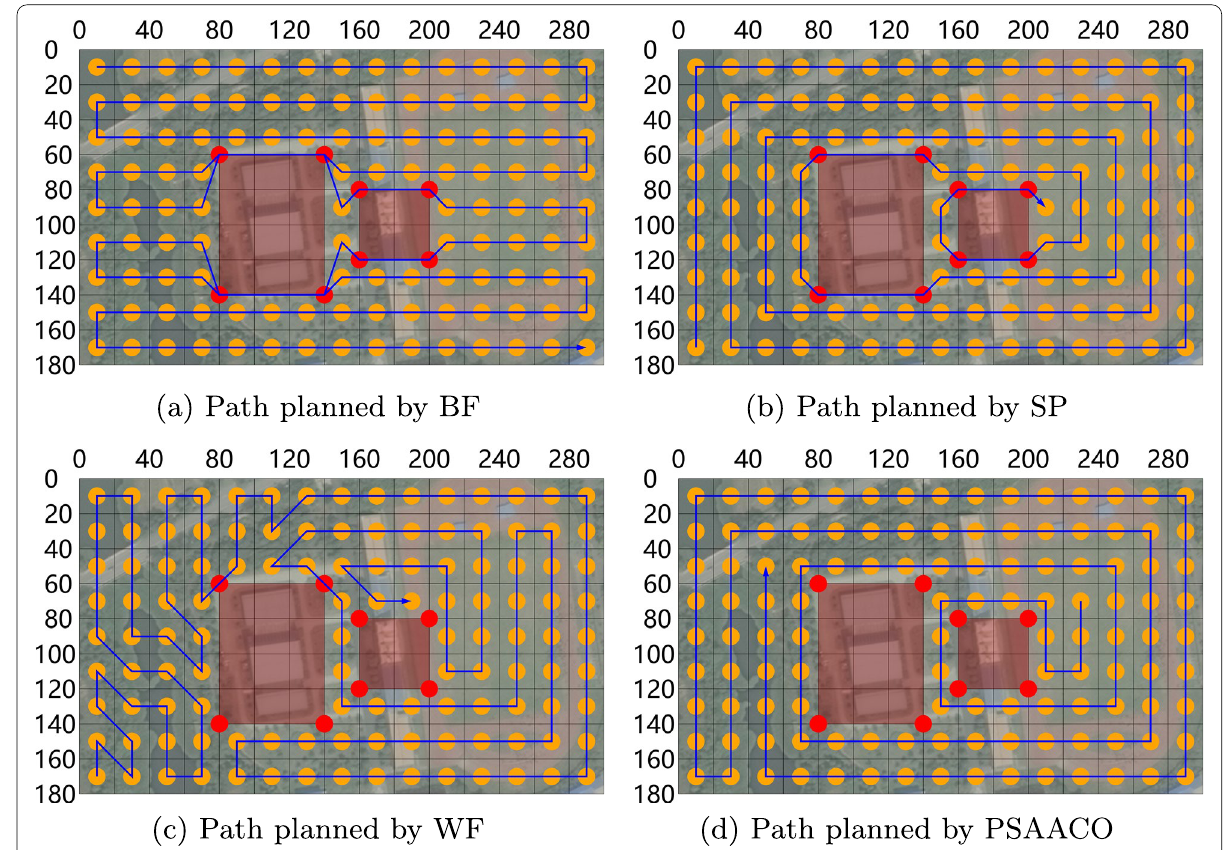
Fig. 17 Paths planned on CPP